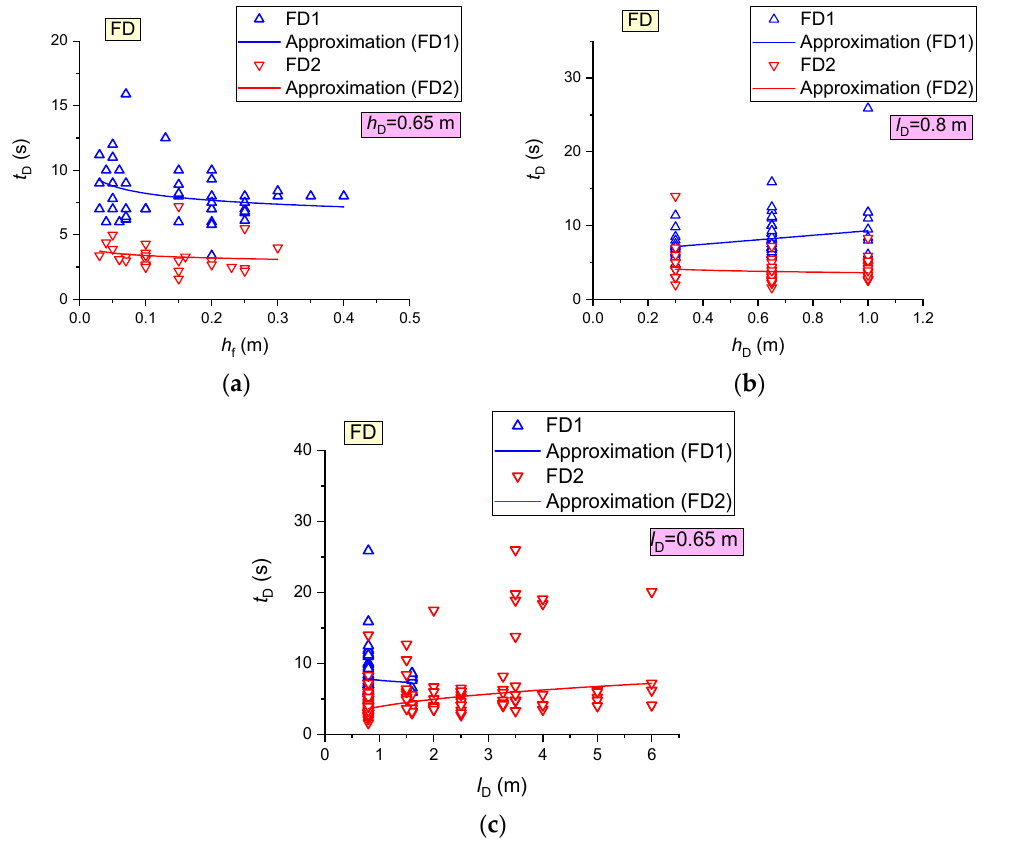
26 of 39 Figure 13. Fire detector (FD and SD) activation delay times versus the fire area during wood combustion (mass of burning materials 50 g): ( a ) SD1, SD2; ( b ) SD3, SD4; ( c ) FD. FD activation delays during wood combustion versus the flame height and detector